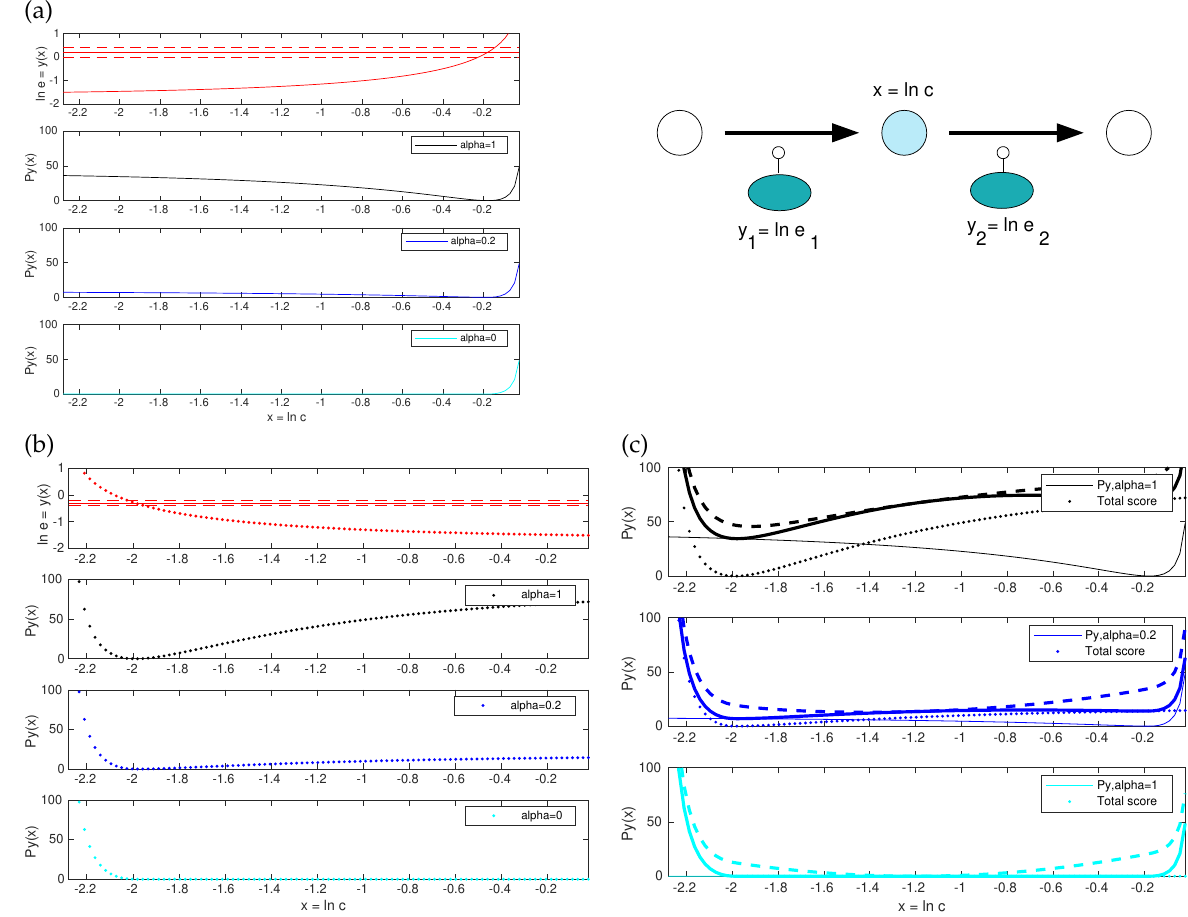
Figure 2. Model balancing and its convex variants. Top right: Example model. Given the fluxes and external metabolite concentrations, the log concentration x determines the enzyme log concentrations y 1 and y 2 . ( a ) Posterior score for the enzyme level in reaction 1. Top: the log enzyme level y 1 depends on the metabolite log concentration x (solid curve). Horizontal lines show the preposterior mean (solid) and standard deviation (dashed). Black line: the posterior score term is zero where y 1 matches the preposterior mean and increases for smaller and larger values. Since the left part of the curve is negatively curved, the function is non-convex. In the plots below, this left part is decreased by a factor α = 0.2 (dark blue) or removed completely by setting α = 0 (cyan). The resulting last curve is convex; ( b ) same as ( a ), for reaction 2. The posterior score has its minimum at a lower x value than for reaction 1; ( c ) Posterior score for x . Top: The enzyme posterior scores for reaction 1 and 2 (solid and dotted black curves from ( a , b )) are added (thick solid line). By further adding the metabolite term (which is strictly convex), we obtain the posterior score (dashed line), which is non-convex. In the case of α = 0.2 (dark blue), the enzyme term is still non-convex, but the total posterior score becomes convex. In the case α = 0, the enzyme term is convex, and the total posterior score is convex as